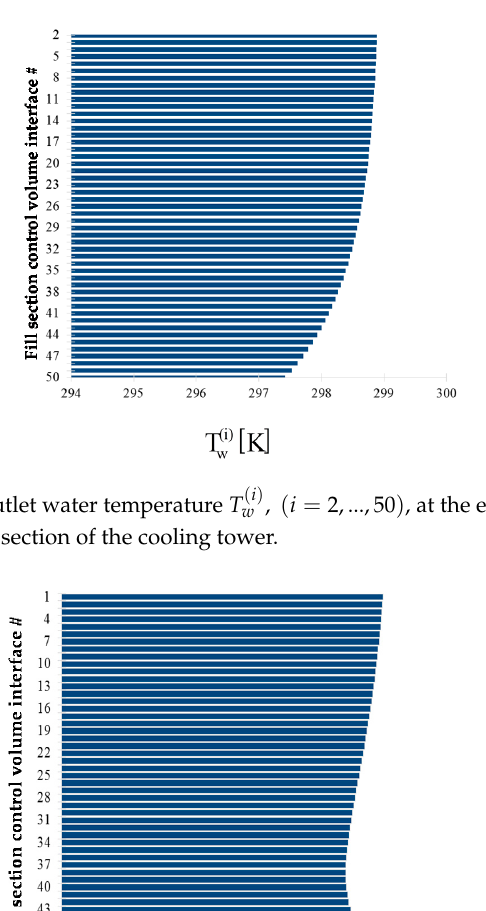
( i ) ( i = 1,...,49 ) , at the exit of each control volume T , ( 1,...,49) = i , at the exit of each control T , ( 1,...,49) = i , at the exit of each control T , ( 1,...,49) = i , at the exit of each control a , a a a